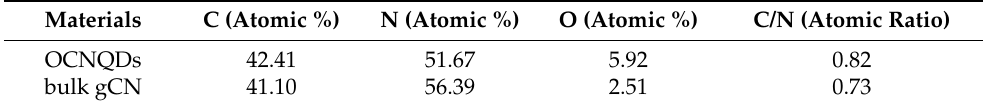
Table 1. Elemental analysis (C, N, O atomic %) of the OCNQDs and bulk gCN performed by XPS.